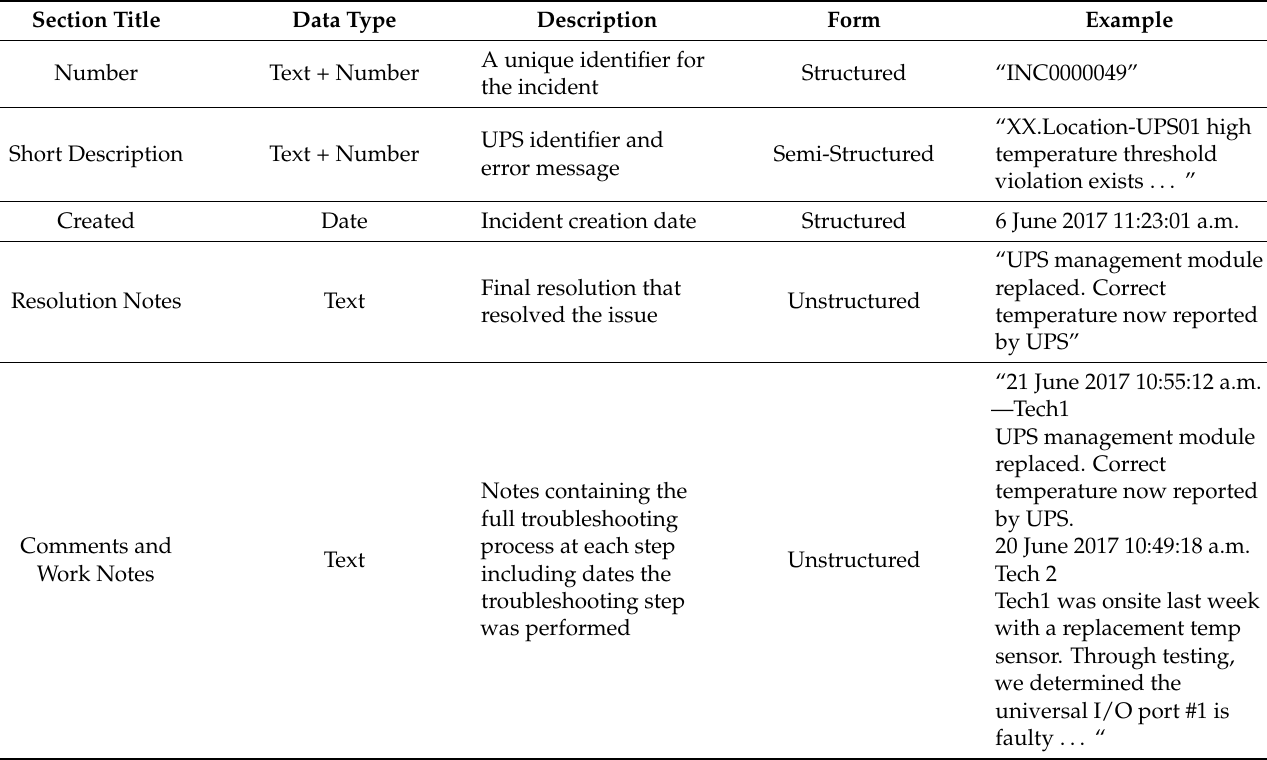
Table 4. Column titles of the raw data along with description of the data it